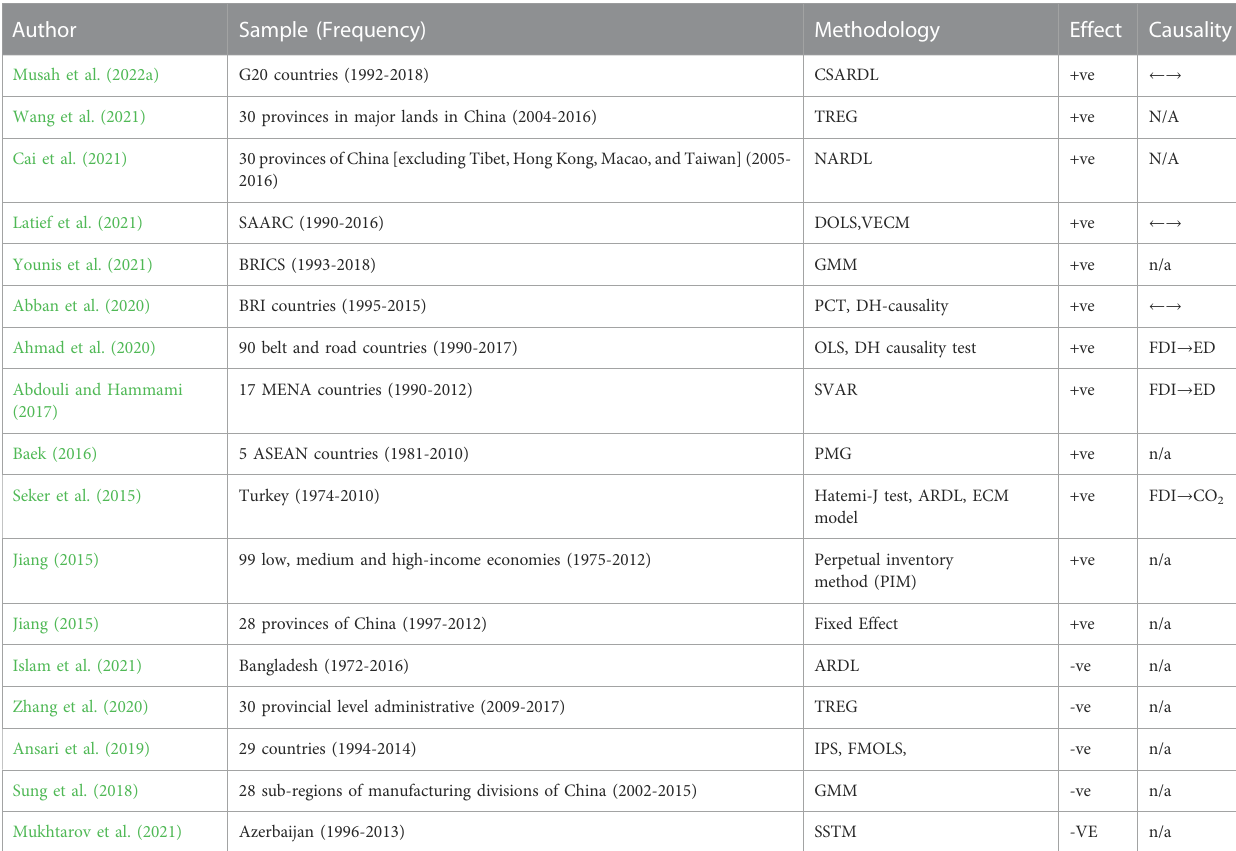
TABLE 2 Literature summary: FDI-led environmental